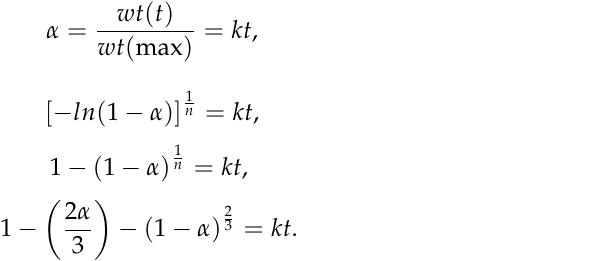
Figure 3. Isothermal dehydriding of cryogenically prepared Mg-15wt.% VCl 3 , previously hydrided at the indicated temperature. All dehydrogenations at 350 °C and 0.8 bar.